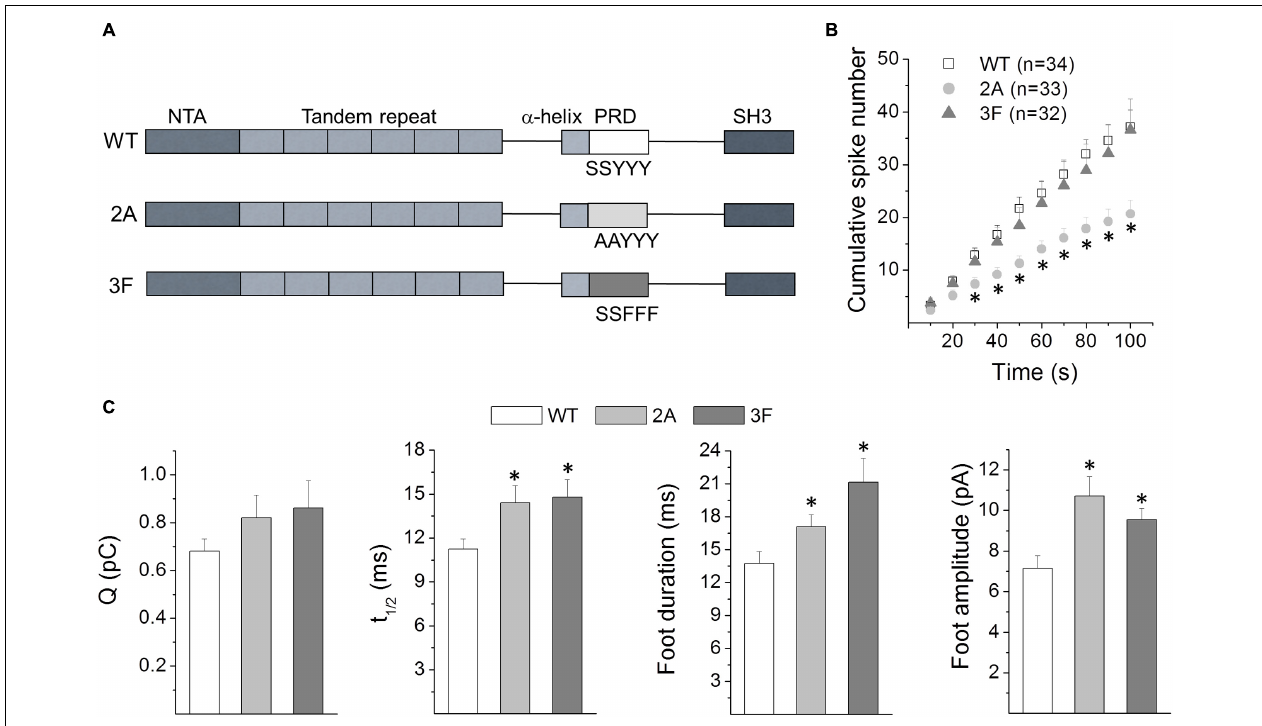
FIGURE 6 | Effects of serine and tyrosine phosphorylation of cortactin on exocytosis. (A) Schematic representation of the cortactin primary structure and the location of the mutations used in this study. (B,C) Cells were transfected with WT, the ERK1/2 non-phosphorylatable mutant S405,418A (2A) or the Src non-phosphorylatable mutant Y421,466,482F (3F). Exocytosis was induced with 50 µ M DMPP and monitored by amperometry 48 h after transfections. Each amperometric recordings lasted 100 s. (B) Cumulative histograms of the number of amperometric events from cells expressing WT or the phosphorylation-resistant mutants 2A or 3F. Numbers between parentheses indicate the number of cells obtained from at least three different cultures. Note that in comparison to the WT-expression, the 2A mutant significantly reduced the number of exocytotic events during the last 80 s. ∗ p < 0.05 compared with WT (one-way ANOVA followed by unpaired t -test). (C) The graphs show mean values of medians determined for individual cells of the quantal size (Q), half width (t 1 / 2 ) foot duration and foot amplitude of the amperometric spikes from cells expressing WT (white bars), 2A (light-gray bars) or 3F (dark-gray bars). Data are represented as means ± SEM. Numbers of cells for each condition are the same as indicated in (B) . ∗ p < 0.05 compared with WT (one-way ANOVA followed by unpaired t